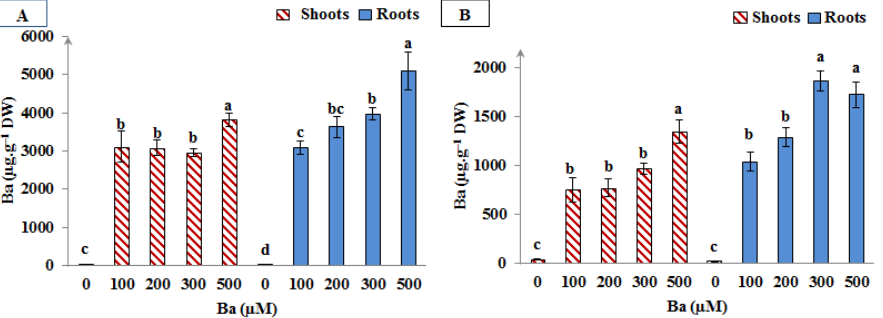
Figure 5. Barium content in shoots and roots of Limbarda crithmoides ( A ) and Helianthus annuus ( B ) after 45 days of Ba treatment. Data are presented in mean values ± SD, n = 10. Bars marked with different lower-case letters were significantly different at p < 0.001.